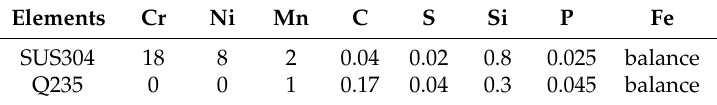
Table 1. Chemical composition of stainless steel and carbon steel (wt. %).